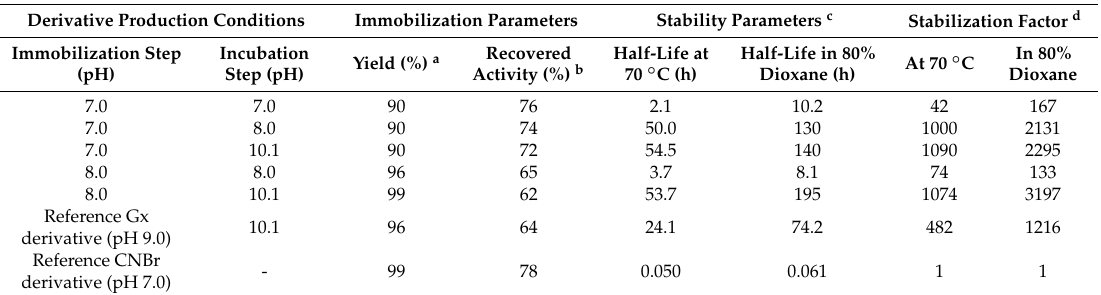
Table 3. BTL2 immobilization on Gx in presence of 20 mM DTT (except for the references) and derivative